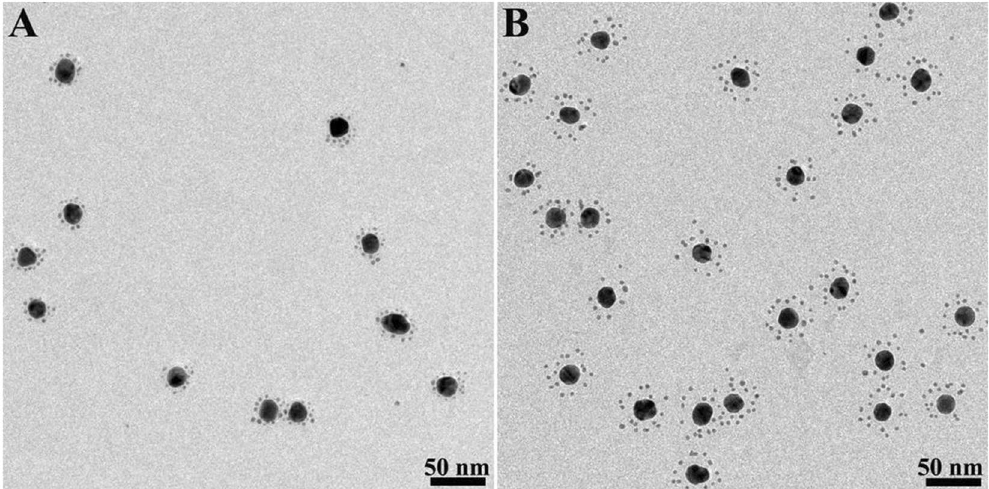
Figure 5. TEM images of the PEG-CSAuNAs prepared at the 1:160 molar ratio ( A ) before and ( B ) after incubation with 10% FCS for 6